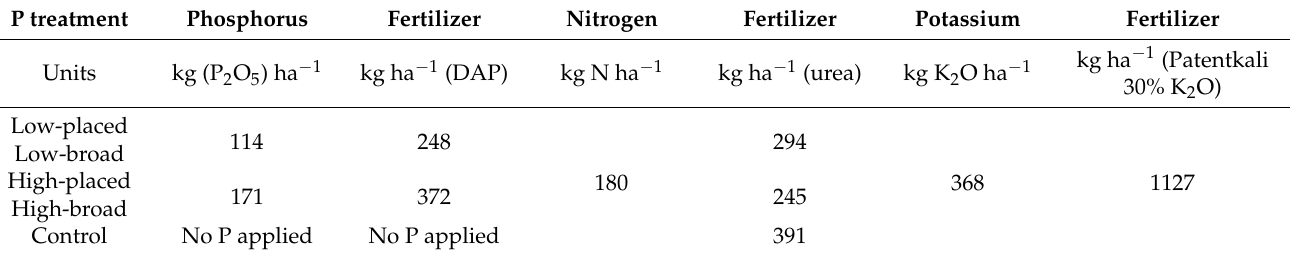
Table 1. Description of the experimental design for silage maize.